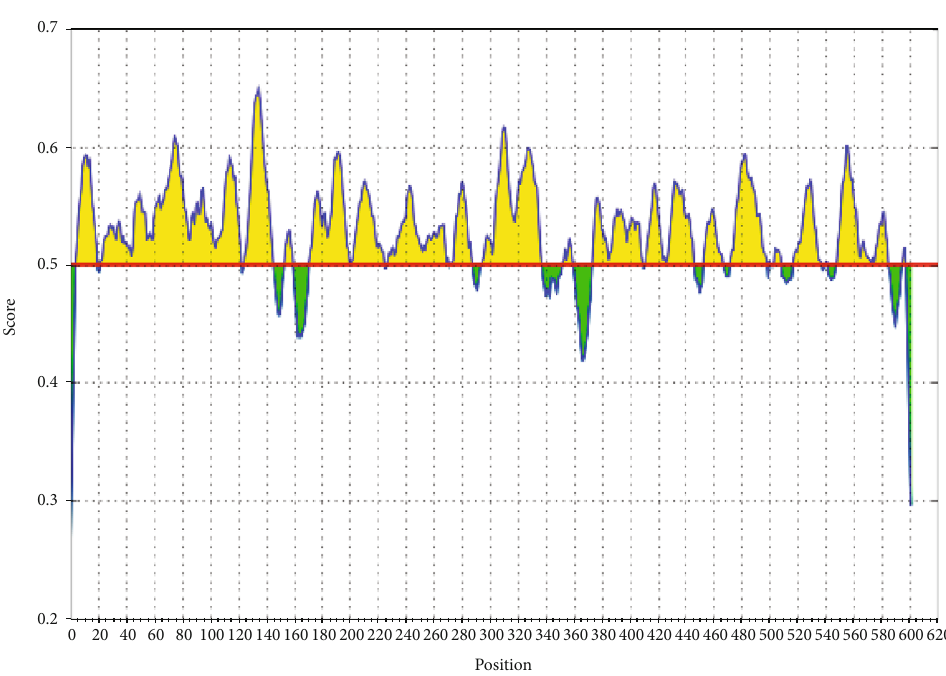
Figure 2: Emini surface accessibility prediction. Areas above the red line (threshold) are epitopes suggested to be binding to the B cells while the green areas are